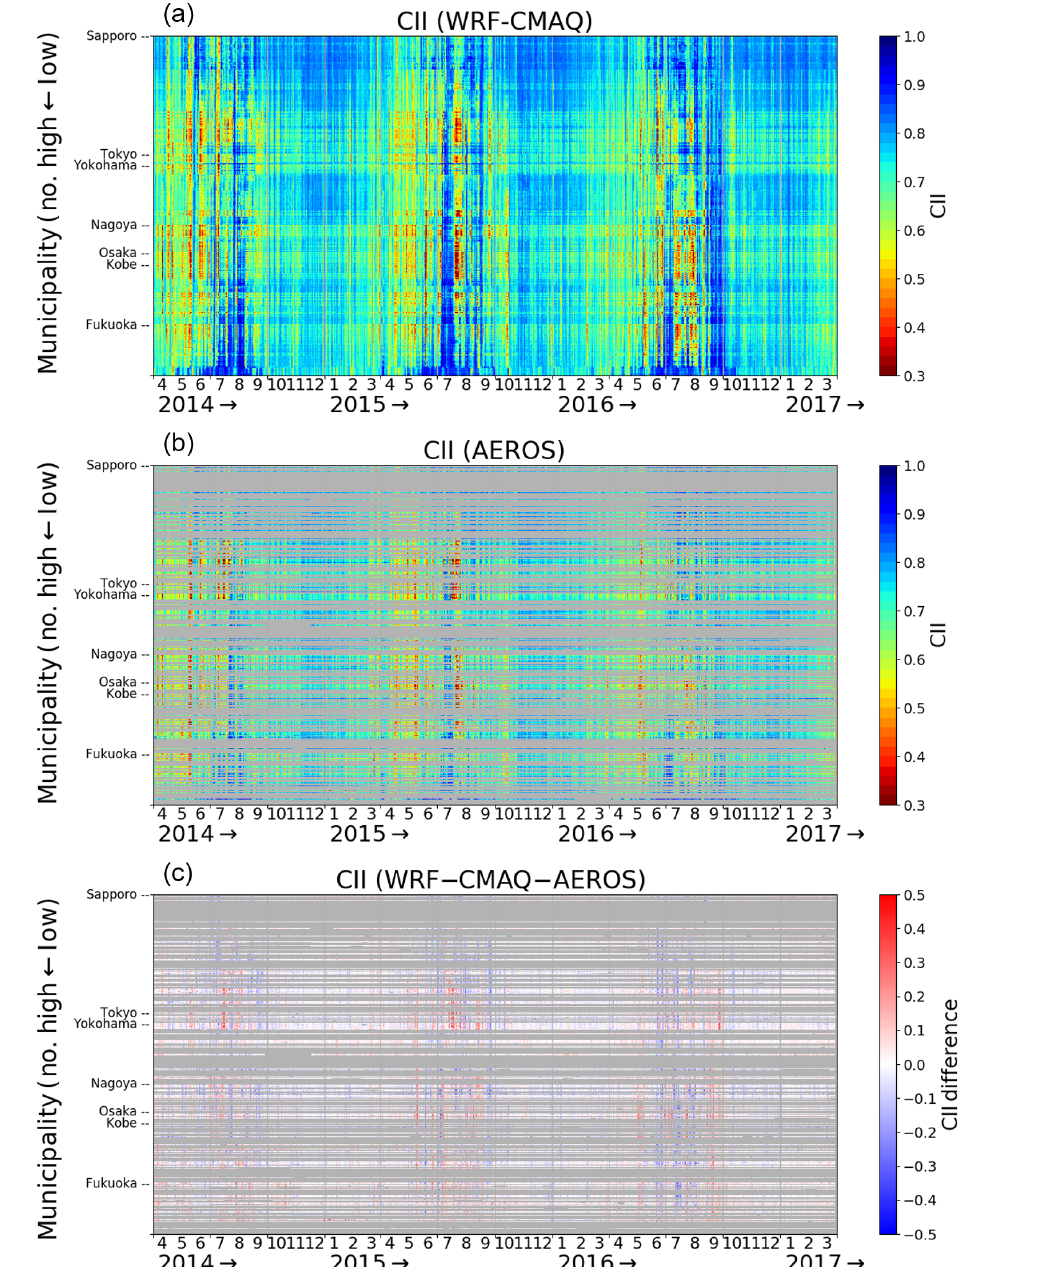
Figure 2. Spatiotemporal variation in CII values derived from (a) the WRF–CMAQ model, (b) the AEROS measurements, and (c) their difference (WRF–CMAQ–AEROS). The horizontal and vertical axes correspond to the date of the study period and Japanese municipal number, respectively. The municipalities where the AEROS observation covered less than 20% of days in the study period are shaded in